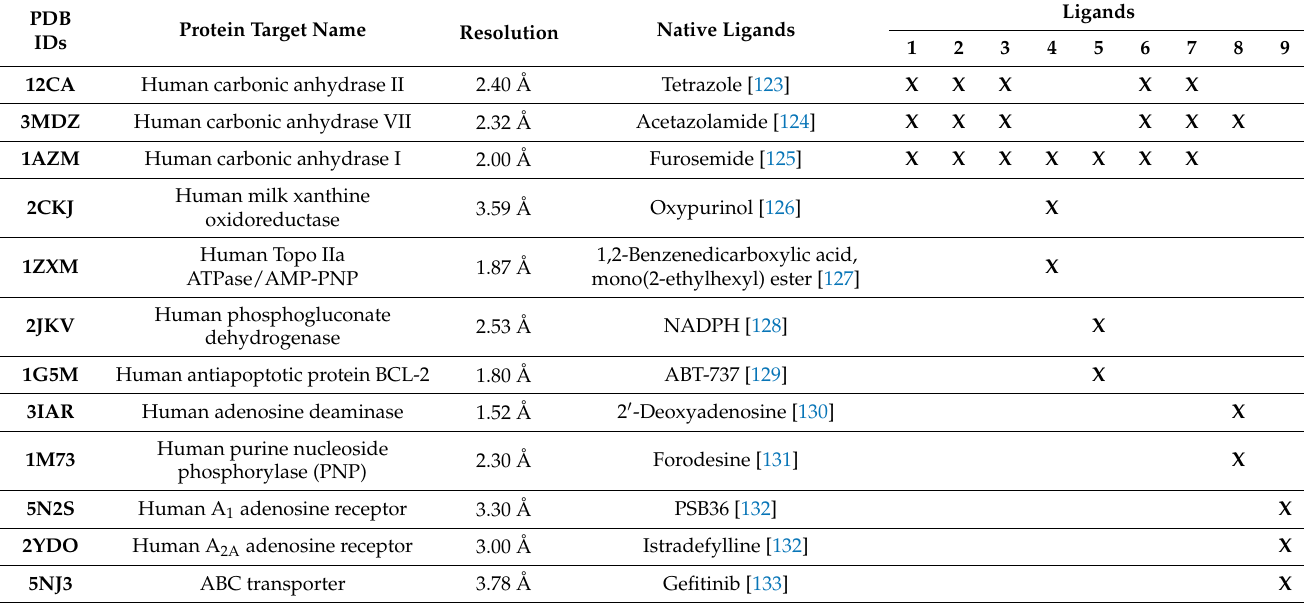
Table 10. Target proteins of the identified compounds using SwissTarget Prediction. (1) Gallic acid, (2) syringic acid, (3) trans -ferulic acid, (4) myricetin, (5) catechin gallate, (6) caffeic acid, (7) chlorogenic acid, (8) arbutin, (9)